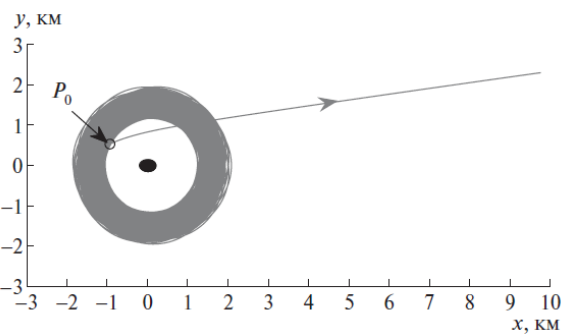
Figure 6. Example of the system’s response to event classified as dangerous.